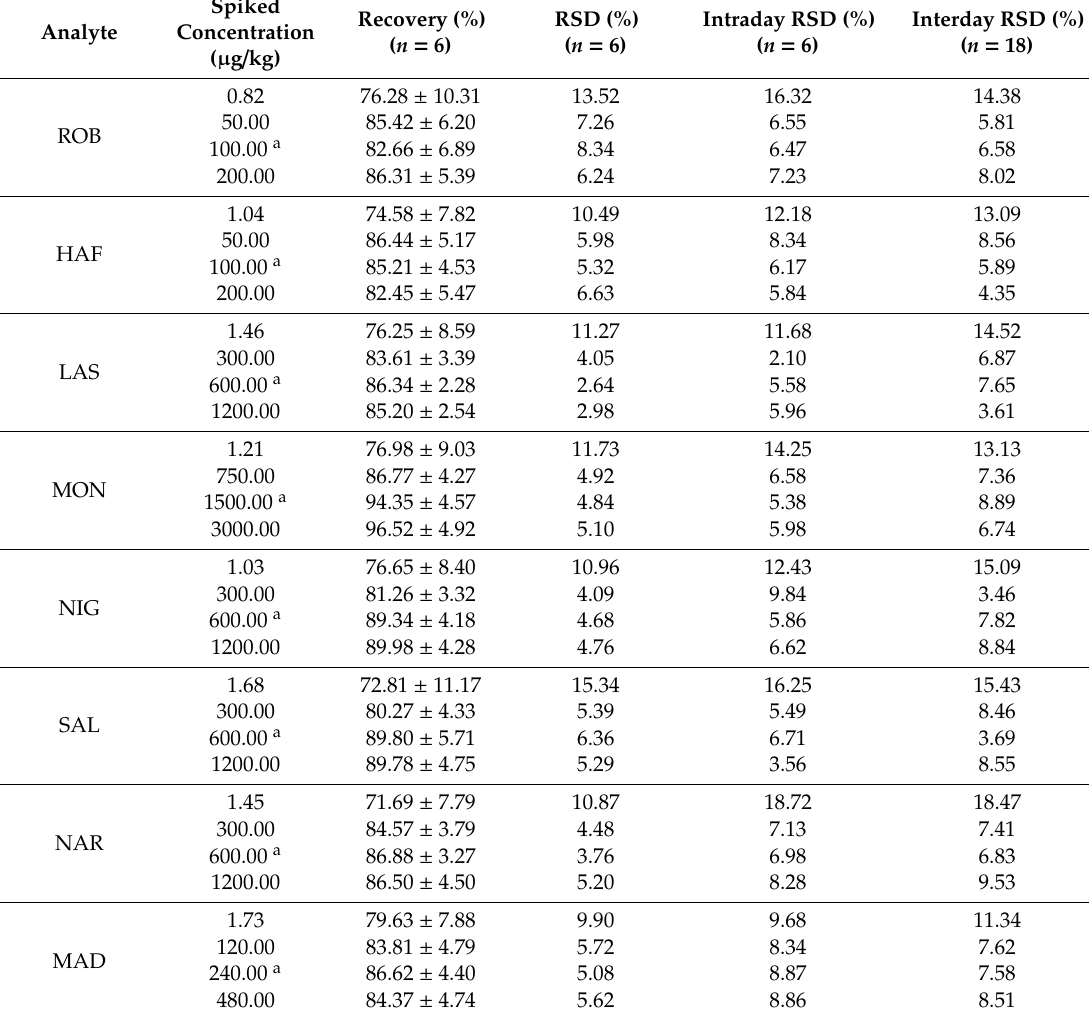
Table 3. Recoveries and precision of eight coccidiostats spiked in blank eggs in HPLC–MS / MS analysis. Analyte